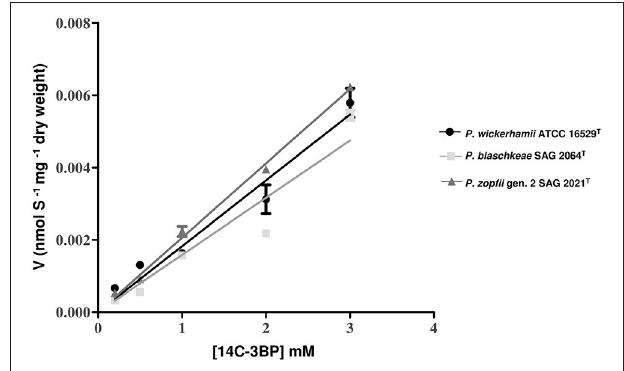
FIGURE 4 | The uptake kinetics of [ 14 C]-labeled 3BP (substrate concentration range: 0–3mM) in different Prototheca spp. strains.